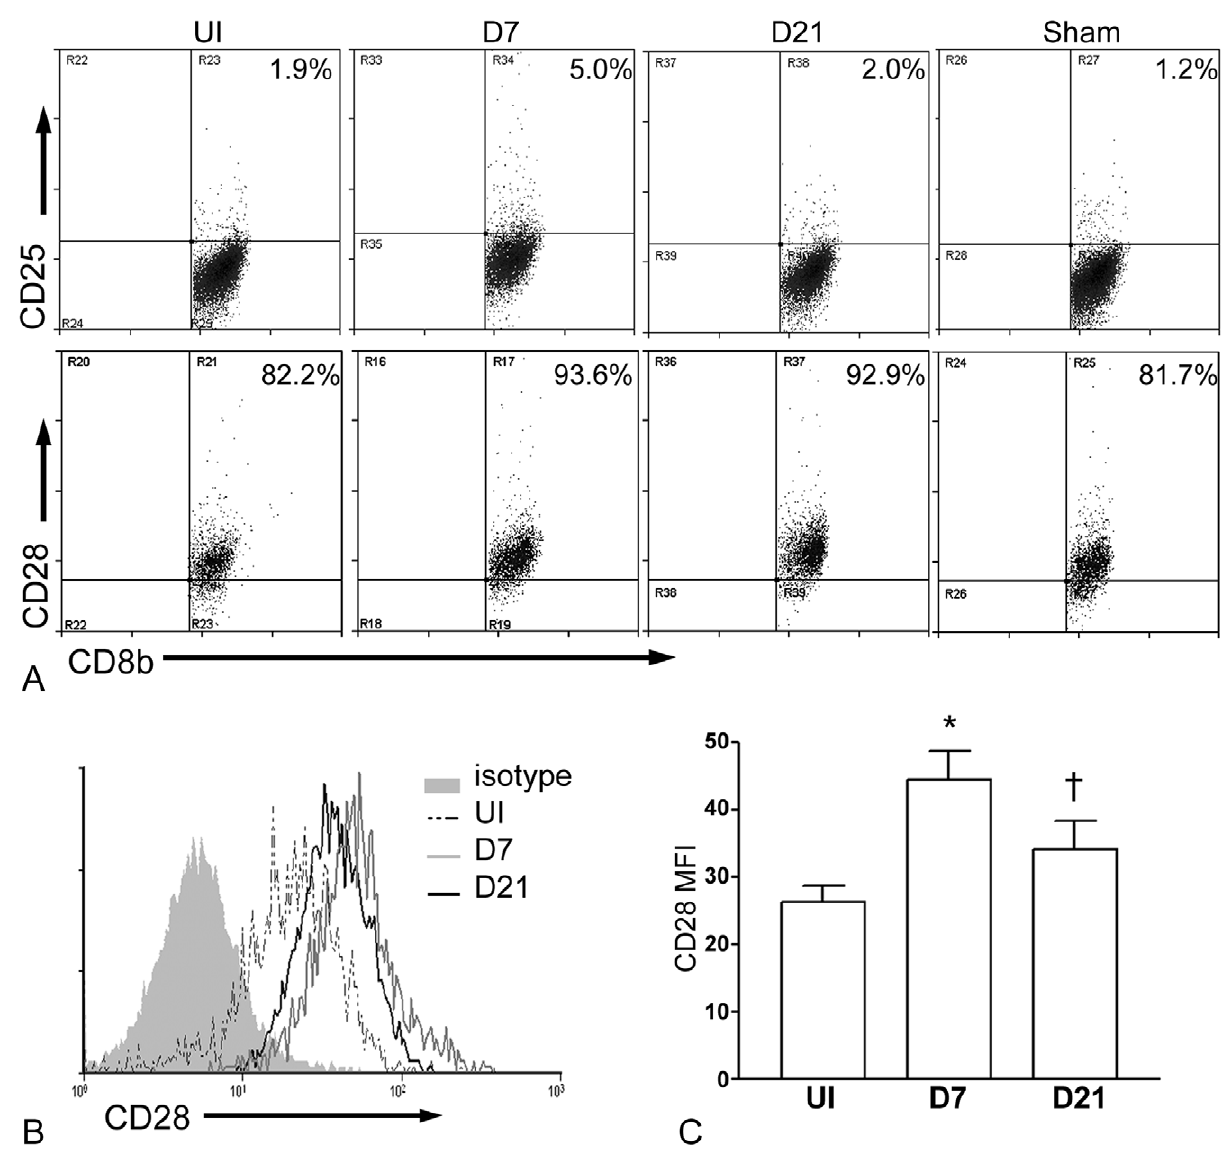
Figure 2. Splenic CD8b + T cells after arterial injury in WT mice. Representative scatter graphs of CD8b-gated CD25 + (A, top panel) and CD28 + (A, bottom panel) spleen T cells. Representative histogram of CD28 expression on CD8b-gated cells (B). Geometric mean fluorescence intensity (MFI) of CD28 on CD8b-gated cells (C; N=3–4 each time point).